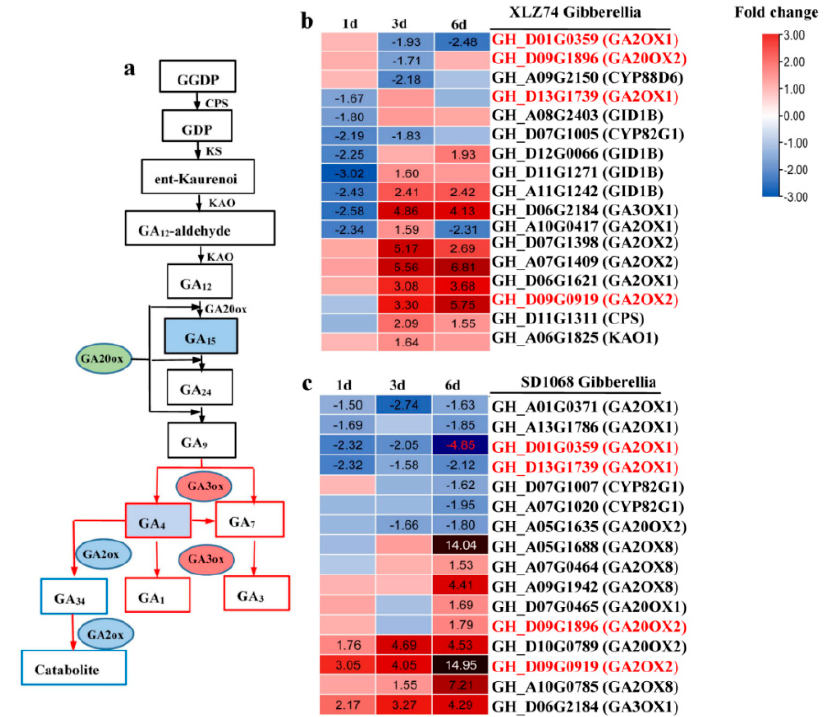
Figure 5. The expression patterns of GA-related genes in XLZ74 and SD1068. The results were based on the RNA-seq data. ( a ) A simple diagram to show the relationship of the genes and GA. ( b , c ) The heatmaps were generated based on the RNA-seq data. The number in box indicates the expression fold change of the gene (only those with a ≥ 1.5-fold difference are shown). MC-induced downregulated and upregulated expression are indicated by blue and red colors, respectively. Gene ID marked with red color represents common gene between XLZ74 and SD1068. All the numbers in heatmap were fold